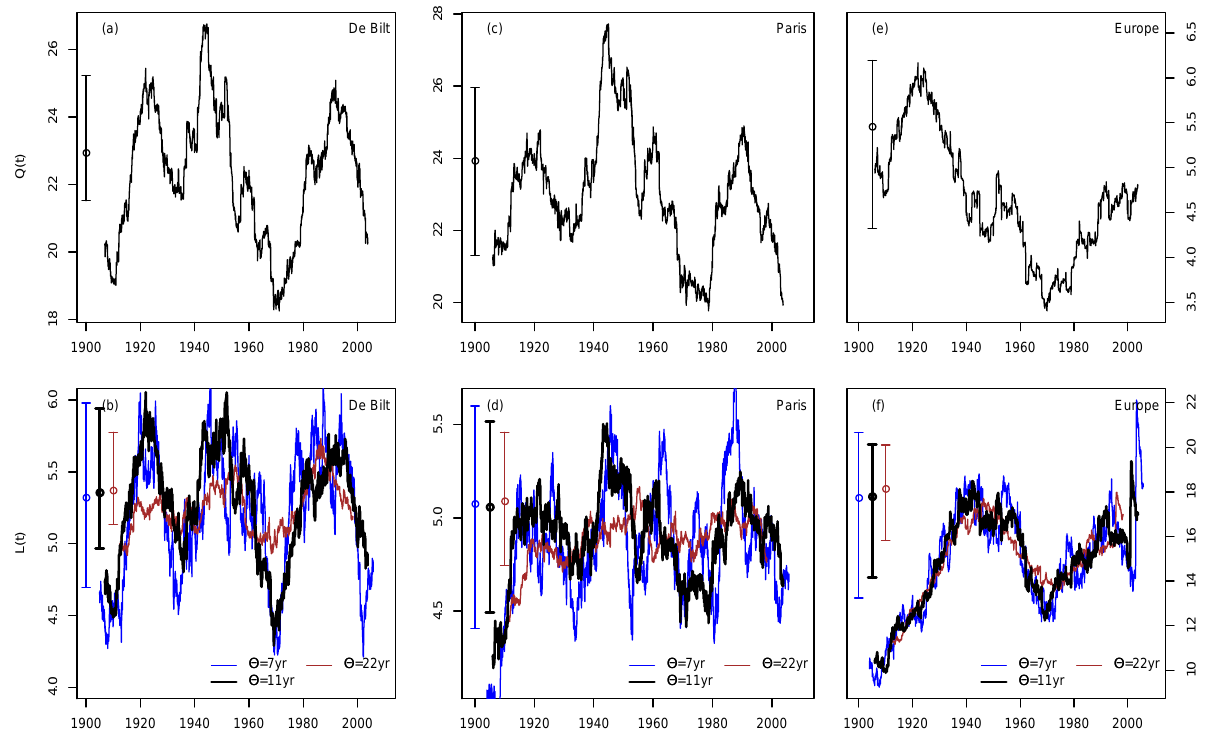
Fig. 4. (a) Variations of daily Q 2 (t) for De Bilt temperature between 1900 and 2008, with 2 = 11 years. (b) Same convention as (a) with L 2 (t) . The colored continous lines show the variations of L 2 (t) when the parameter 2 is varied from 7 years to 22 years. (c) Same as (a) for the mean daily Paris temperature. (d) same as (b) for the mean daily Paris temperature. (e) Same as (a) for the mean daily European temperature. (f) same as (b) for the mean daily European temperature. The vertical confidence intervals indicate the median, 5th and 95th quantiles for the variations of Q 2 (t) (or L 2 (t) ) of an AR(1) process with the same variance and